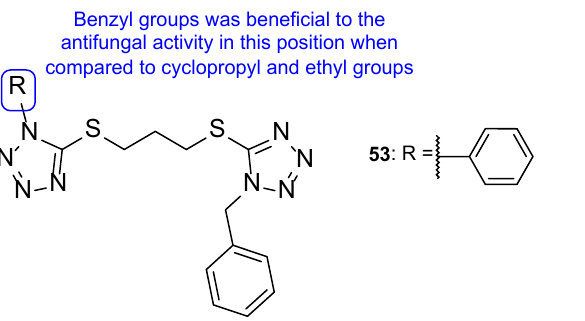
Figure 28. Chemical structure of compound 53 and SAR for this series of tetrazole-tetrazole hybrids [108].